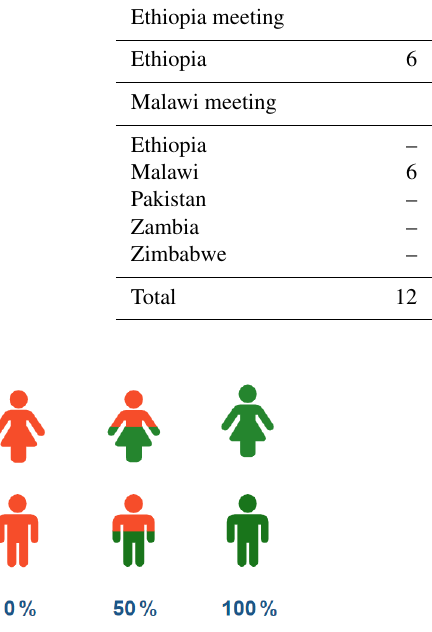
Figure 1. Use of pictographs reporting a probability of an event exceeding a